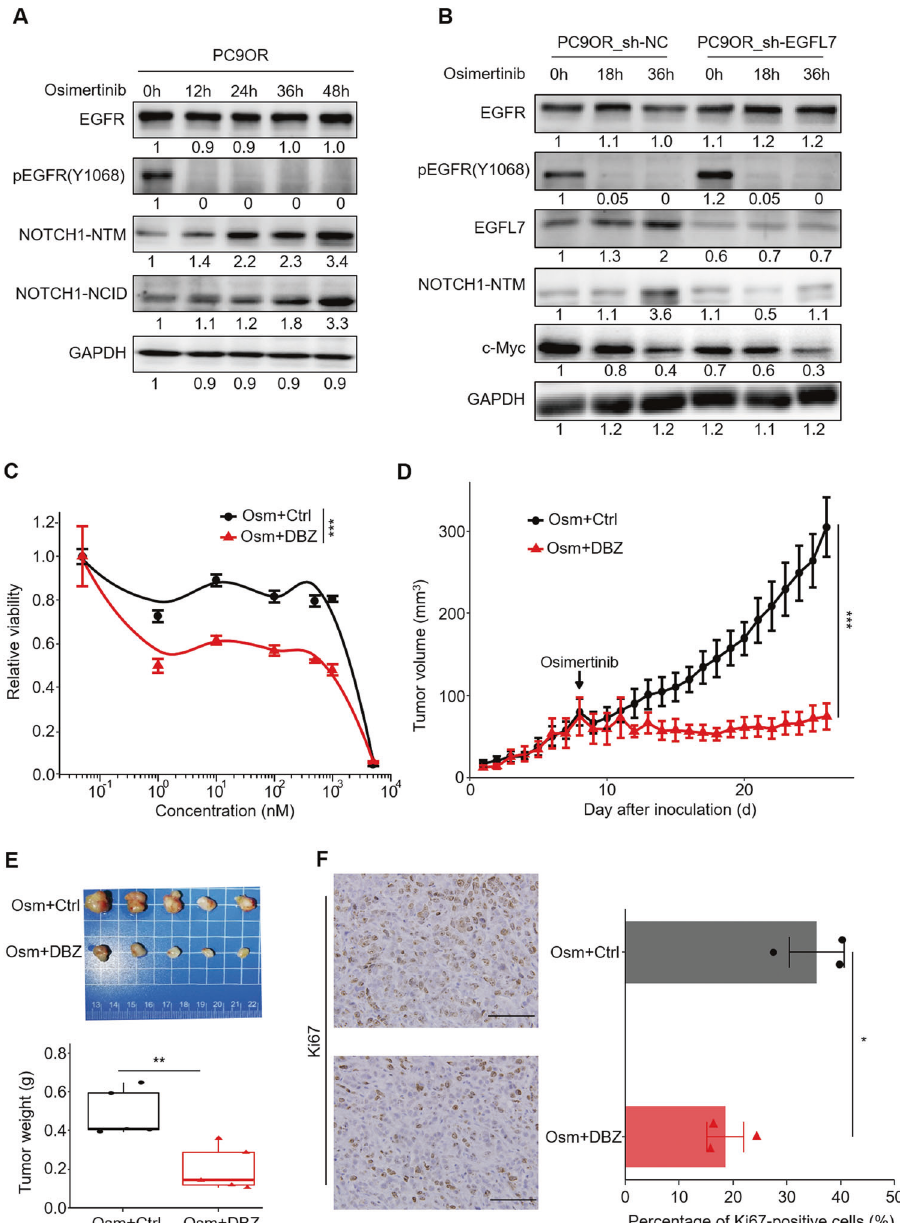
Fig. 7 EGFL7/NOTCH signaling pathway promotes resistance to EGFR inhibitors in irreversible resistant phase. A Western bolt analysis showing the levels of EGFR, pEGFR, NOTCH1-NTM and NOTCH1-NCID in PC9OR cells treated with 2 µM osimertinib (Osm) for the indicated time points. B Western bolt analysis showing the levels of EGFR, pEGFR, EGFL7, NOTCH1-NTM and c-Myc in EGFL7-knockdown PC9OR cells and control cells treated with 2 µM osimertinib (Osm) for the indicated time points. GAPDH was set as a loading control. C Survival curves of PC9OR cells treated with a combination of different concentrations of osimertinib (Osm) and vehicle control (DMSO) or NOTCH signaling inhibitor dibenzazepine (DBZ) for 72 h. Data present as average of four identically wells of percentage of surviving cells to vehicle-treated control. D Growth curves of tumor xenografts derived from PC9OR cells treated with a combination of 3 mg/kg osimertinib (Osm) and 1 mg/ kg DBZ or vehicle control (DMSO). E Images of xenograft tumors with the indicated treatments (upper panel) and statistical analysis of tumor weight (lower panel). F Left panel showing the representative images of Ki67 staining in xenograft tumors with the indicated treatments, and right panel showing statistical analysis of the percentage of Ki67 positive cells. Scale bar: 100 µm. The data in E are average value of fi ve biological replicates. The median line in E represents median value. The top and bottom of box in E are 25th and 75th percentiles. The data in left panel ( F ) show the representative images of three biological replicates, and the data in right panel ( F ) show the average of three biological replicates. Data are shown as mean ± SEM. p values in C , D are calculated by two way ANNOVA, while p values in E , F are calculated by unpaired two-tailed Student ’ s t test (* p < 0.05; ** p < 0.01; *** p < selection of previous existent state. Similarly, the treatment of the evolution to resistance identi fi ed here somehow mimics cell MAPK inhibitors has also been linked with differentiation [50]. This differentiation during which cells tune their function from will complement the model of acquired resistance and may proliferation to facilitate differentiation [49], supporting that bene fi t targeted therapy. drug-tolerant state is a transform of naive state rather than a